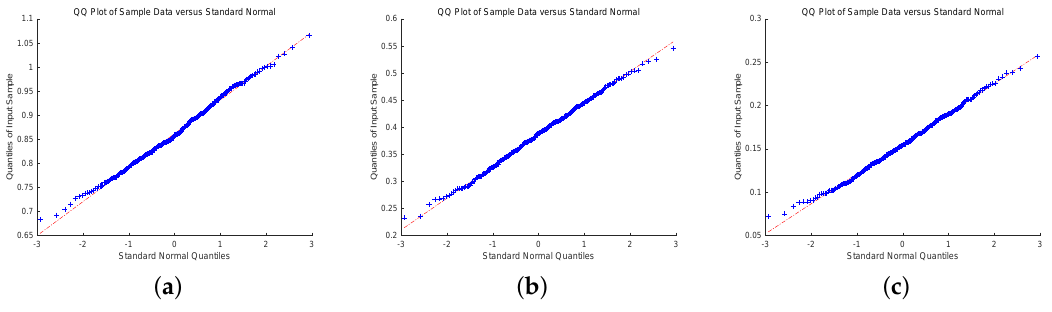
Figure 4. QQ-plot of ECS for Erlang(2) density with T = 1440: ( a ) u = 1; ( b ) u = 3; ( c ) u = 5.